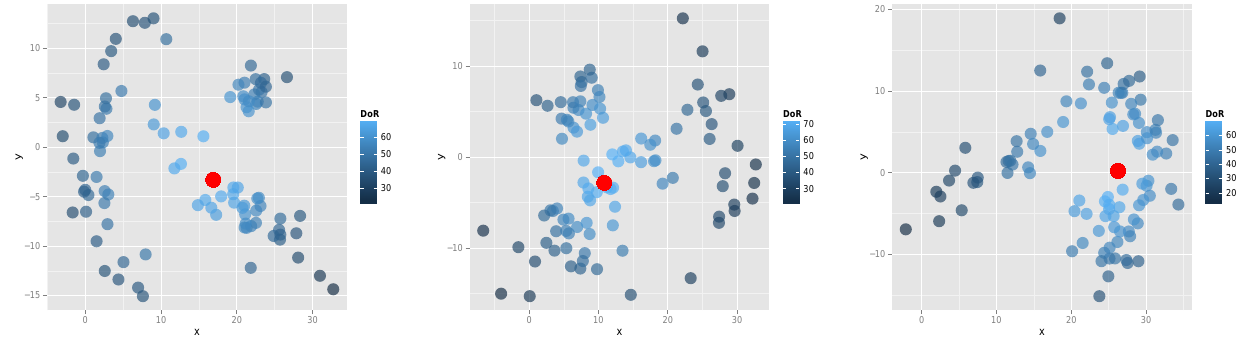
Figure 2. Standard examples (in red) for respectively the datasets (A), (B), and (C). The datasets have 100 random samples. The DoR of the standards are respectively 68.75, 70.55, and